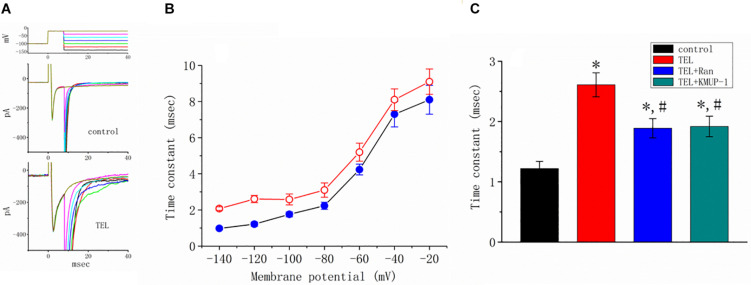
Effects of telmisartan (TEL) and TEL plus Ran on peak and late components of INa identified in mHippoE-14 neurons. The conditioning pulses were briefly depolarized from −80 to −20 mV for a duration of 8 ms. After the conditioning pulse, the membrane potential was set at different potentials ranging from −140 to −20 mV in 20-mV increments to elicit late INa. (A) Superimposed current traces obtained in the control (upper) and during cell exposure to 3 μM TEL (lower). The upper part denotes the voltage protocol delivered. (B) Relationship of membrane potential versus the inactivation time constant (t) of late INa obtained in the absence (⚫) and presence (○) of 3 μM TEL (mean ± SEM; n = 7–9 for each point). (C) Summary of the data showing effects of TEL (3 μM), TEL (3 μM) plus Ran (10 μM), and TEL (3 μM) or KMUP-1 (10 μM) on the inactivation time constant of late INa (mean ± SEM; n = 7–9 for each bar). *Significantly different from the control (p < 0.05) and #significantly different from the TEL (3 μM)-alone group (p < 0.05).